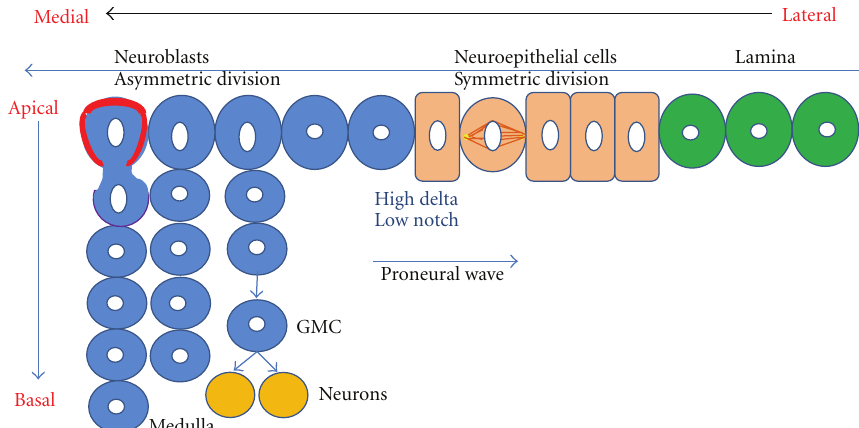
Figure 3: Schematic representation of neurogenesis in optic lobe development. During larval development transition from neuroepithelial (NE, orange) to neuroblast (NB, blue) takes place. NE cells undergo symmetric proliferation with a horizontal spindle orientation to expand the pool of precursor cells and give rise to asymmetrically dividing NB (green). This is in response to the proneural wave of lethal of scute . The median NB divides asymmetrically with a vertical spindle orientation, owing to the clear subcellular localization of the apical (polarity proteins, red boundary) and basal (cell-fate determinants and their adaptor proteins, purple boundary) complex, to give rise to the Ganglion mother cells (GMCs) and further, post mitotic neuronal daughter cells. Most central brain neuroblasts during embryonic and postembryonic stages undergo asymmetric cell divisions [21, 27,